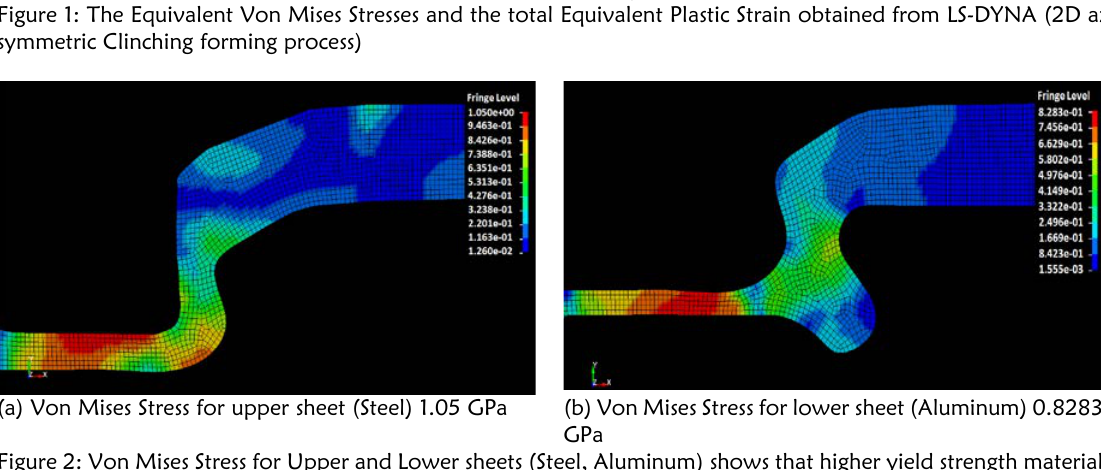
Figure 2: Von Mises Stress for Upper and Lower sheets (Steel, Aluminum) shows that higher yield strength material has higher Von Mises values